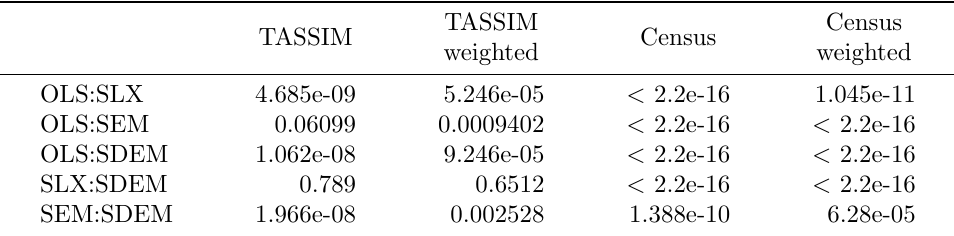
Table 2: Likelihood ratio test p-values for nested pairs of fitted models and two weighing choices for the 96 TASSIM zones and the 489 census tract data sets; model pairs are shown as NESTED:NESTING combinations, and the test is for the lack of significance in fit between the nested and nesting